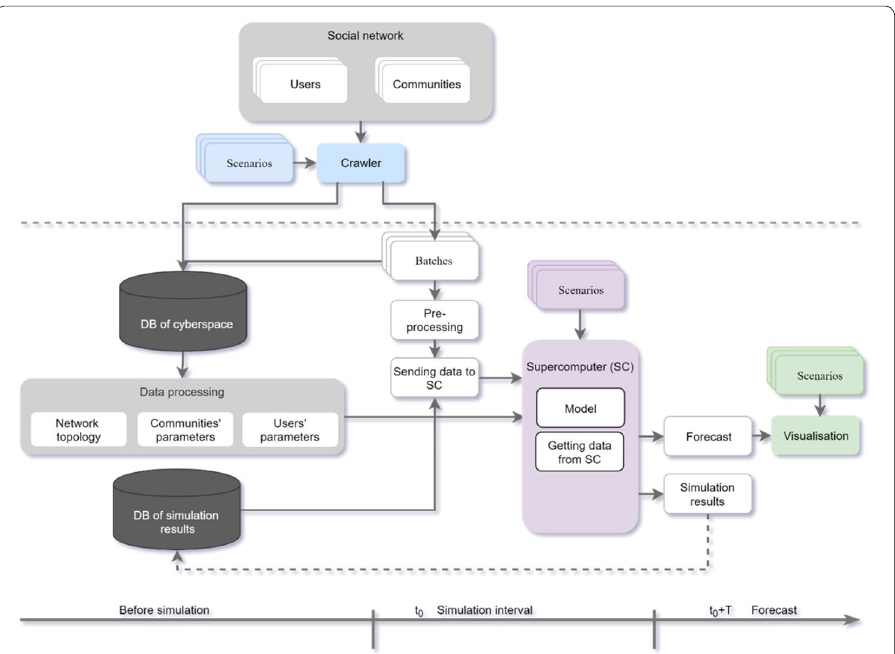
Fig. 5 General architecture of the system of operational forecasting of information processes in